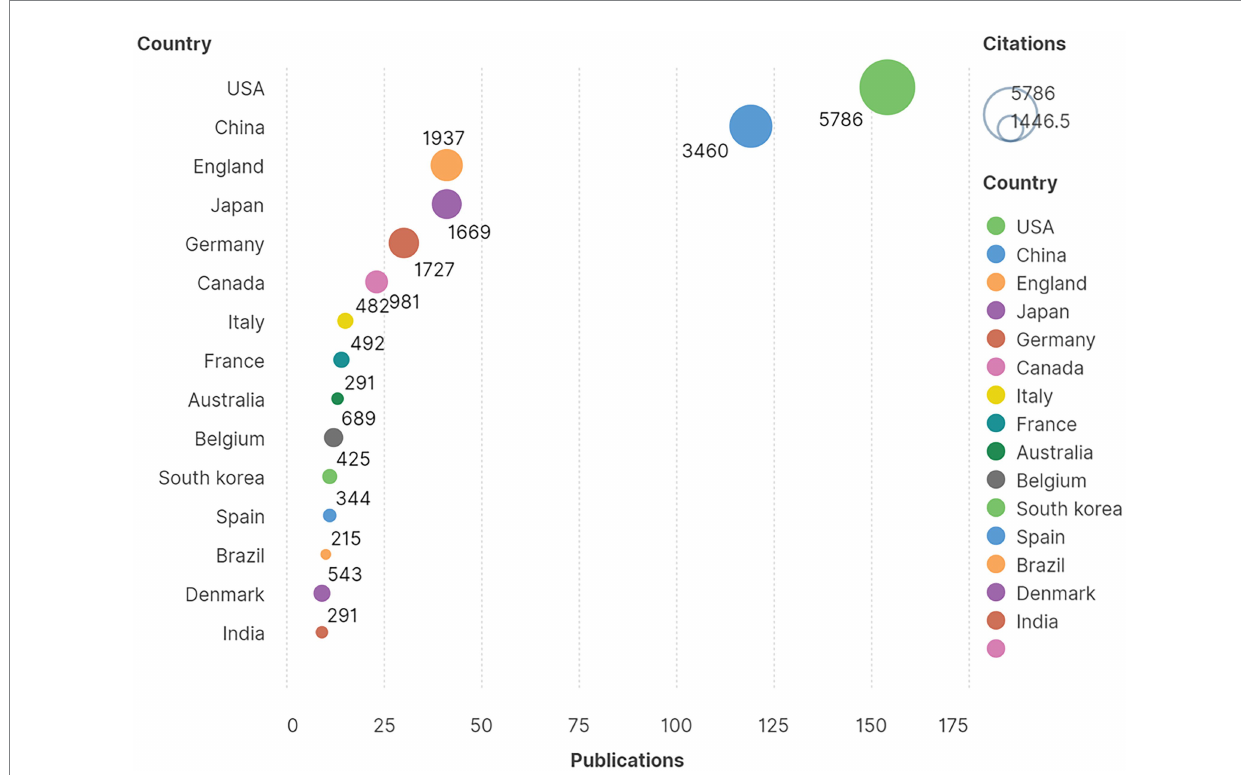
FIGURE 4 The 15 most prolific countries and regions were listed with the number of publications and citations.